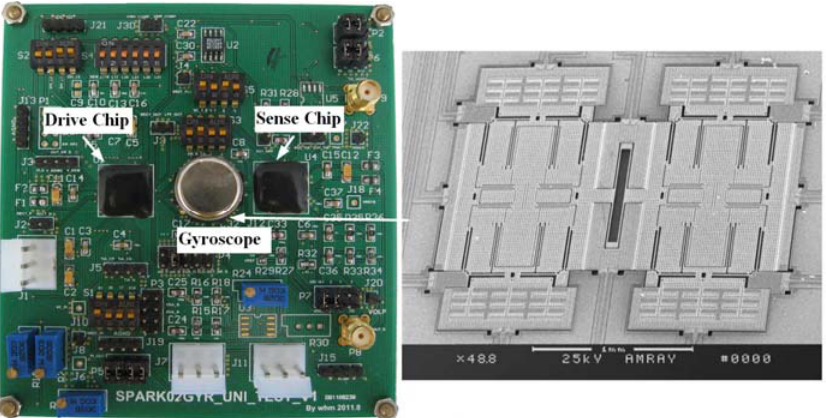
Figure 10. Test board of the gyroscope